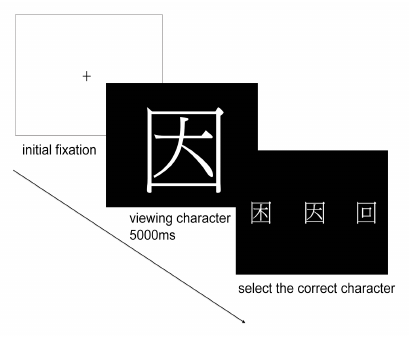
Figure 3. Experiment flow diagram.